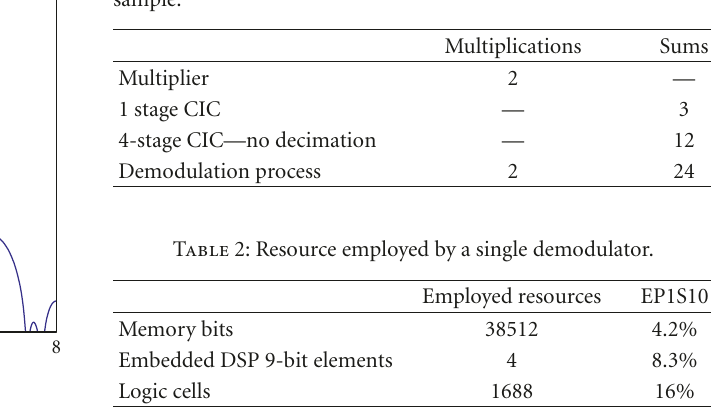
Figure 5: Example of CIC filter response.